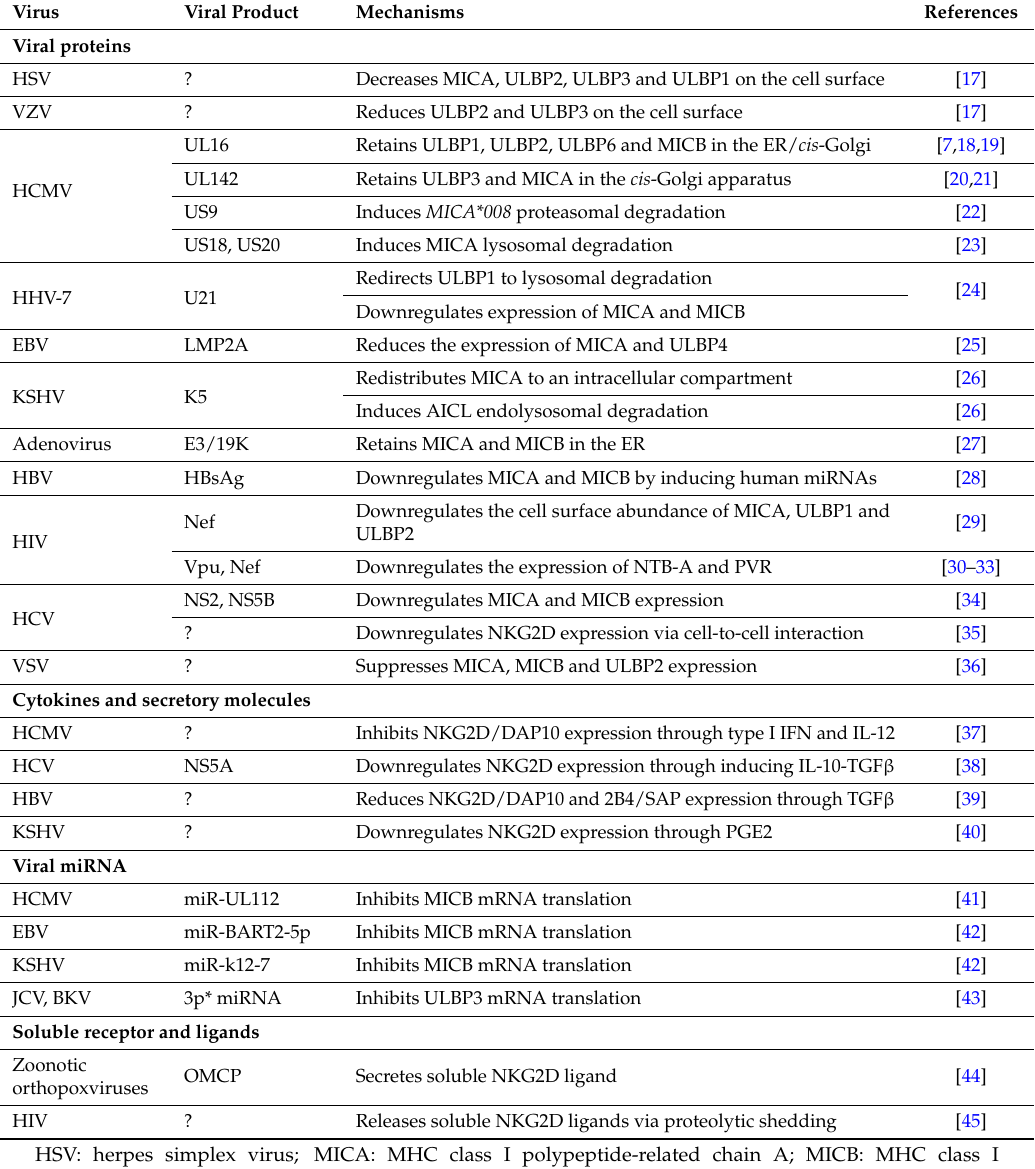
Table 1. Viral gene products and NKG2D-mediated evasion of NK cell